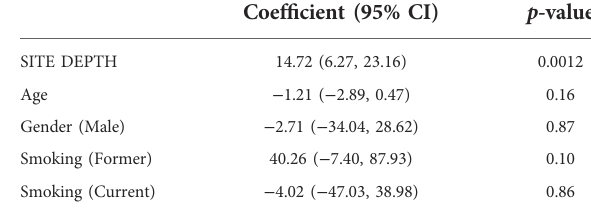
TABLE 2 Multivariate analysis of association between subgingival endotoxin activity levels and site probing pocket depth, adjusted for age, gender and smoking status.